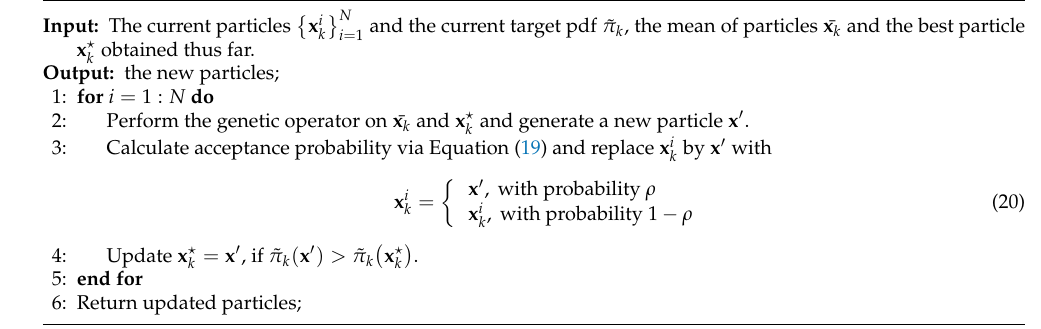
Algorithm 4 A Metropolis sampling method based on genetic